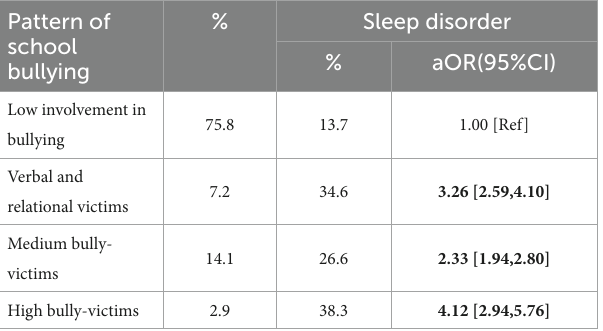
TABLE 5 Multivariate logistic regression between pattern of school bullying and adolescent sleep disorder ( N = 5,724). Pattern of